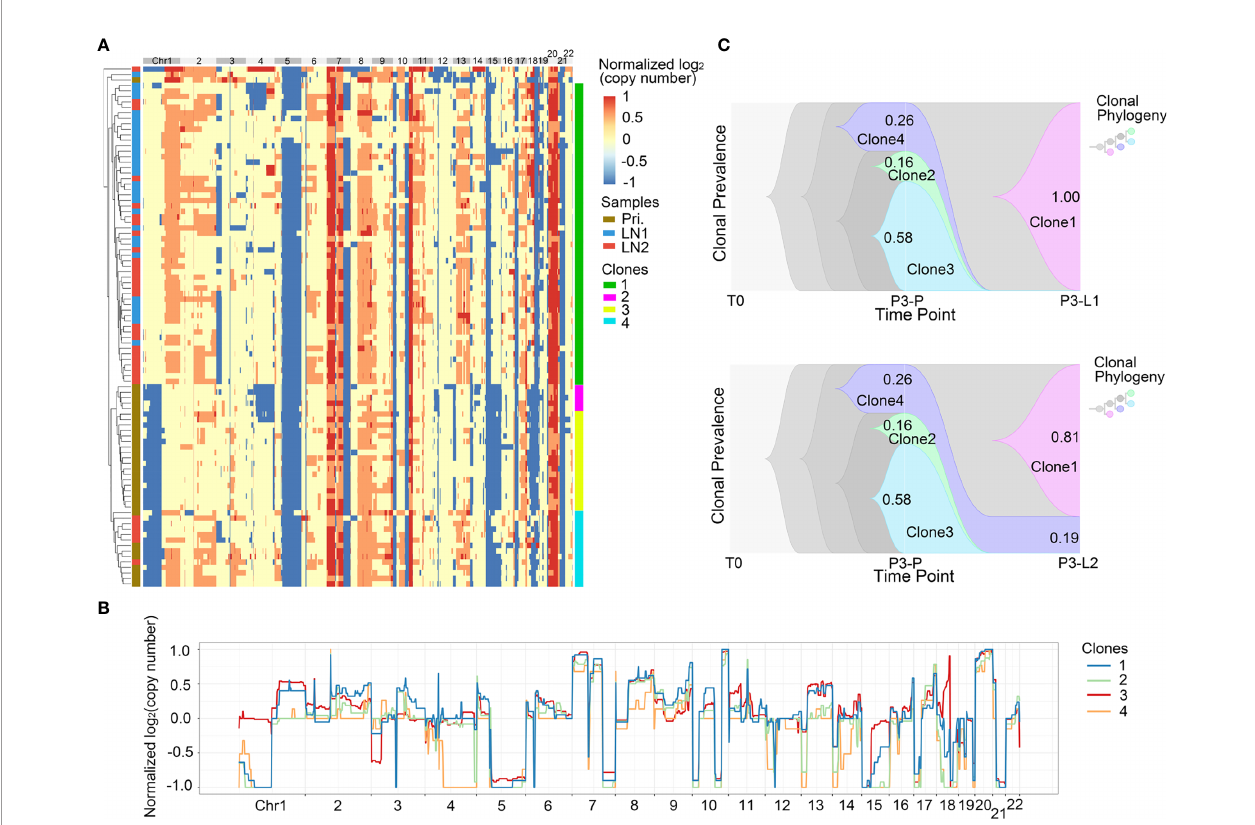
FIGURE 4 | CNV heterogeneity and clonal evolution analysis of primary tumor and lymph nodes in Pt.3. (A) A heatmap of single cell copy number pro fi les in Pt.3 with the clustering analysis based on CNVs on the left. All the cells were divided into four subclones. (B) A plot showed the normalized average copy numbers of the four subclones in Pt.3. (C) The clonal evolution from primary to L1 (upper) and primary to L2 (lower) with the clonal prevalence changes indicated in